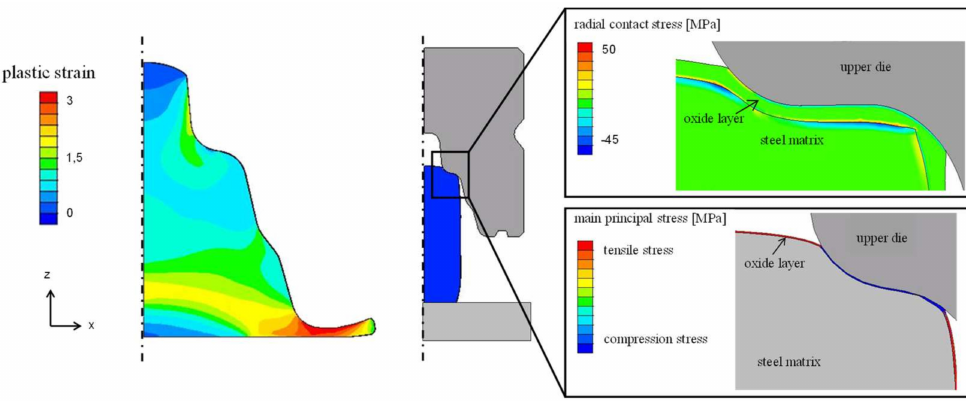
Figure 3. Simulation of the oxide behavior during die